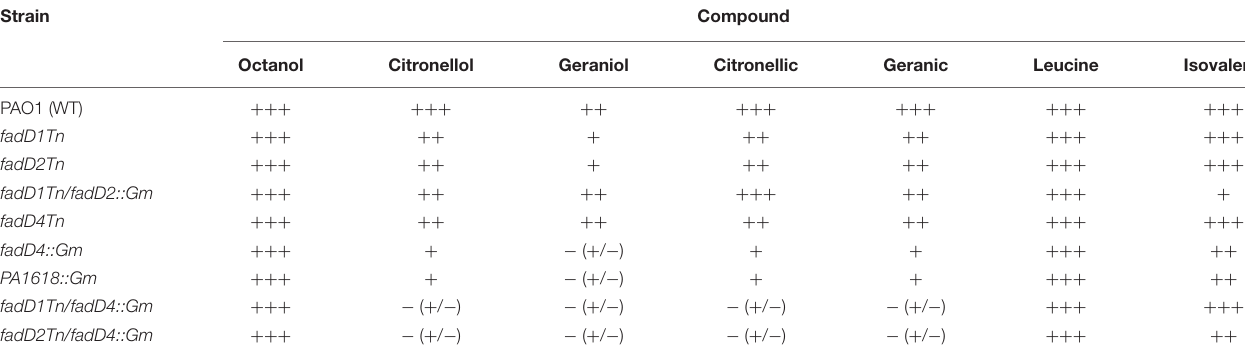
TABLE 2 | Growth analysis of P. aeruginosa strains in different compounds. Strain